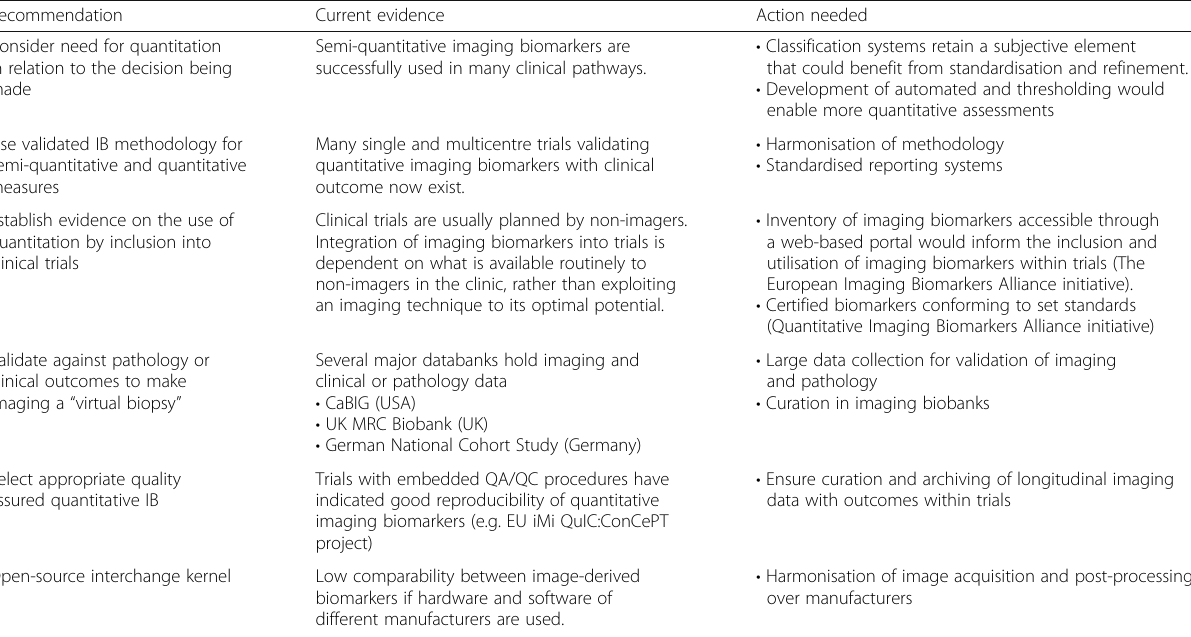
Table 4 Recommendations for the use of quantitative imaging biomarkers as decision-support tools Recommendation Current evidence Action needed